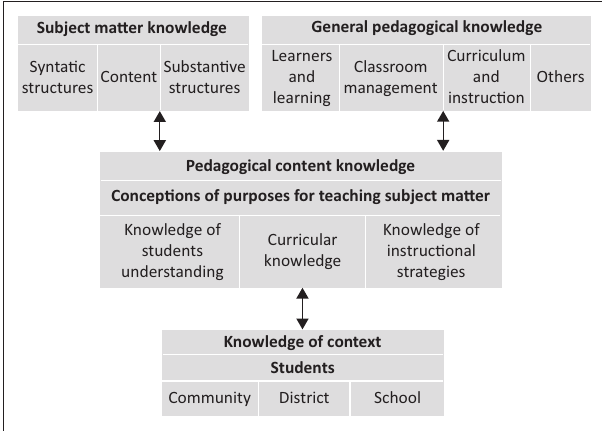
FIGURE 1: Grossman’s model of teacher